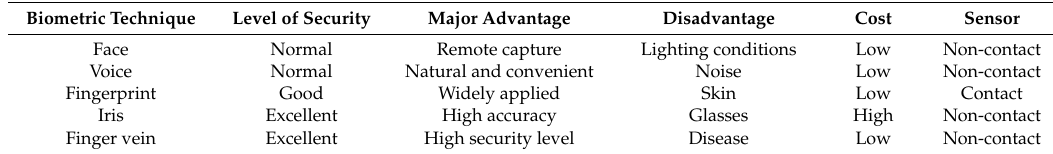
Table 1. Characteristics of typical extrinsic and intrinsic